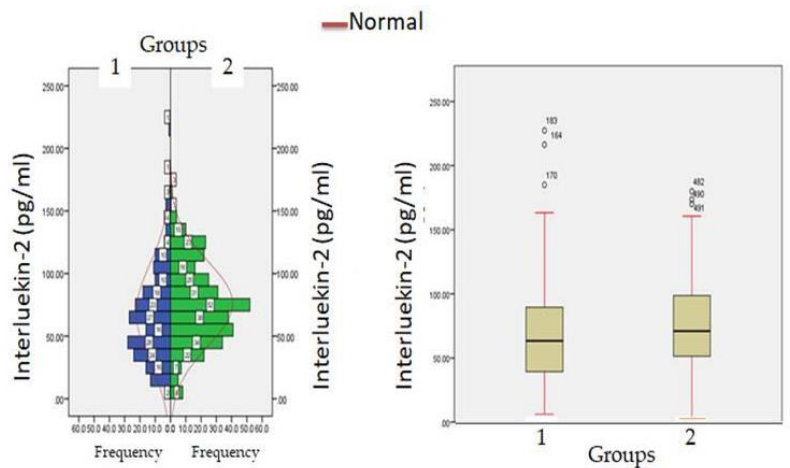
Figure 5. Interluekin-2 levels at admission (hospitalization) in patients with normocreatinemia (Group-I) and hypercreatinemia (Group-2).